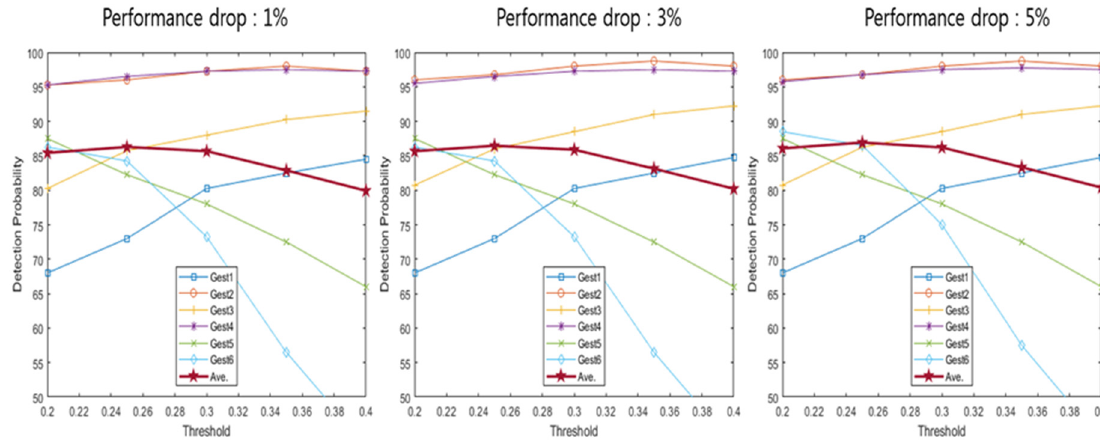
Figure 11. Detection probability of proposed method 1 (window 2).